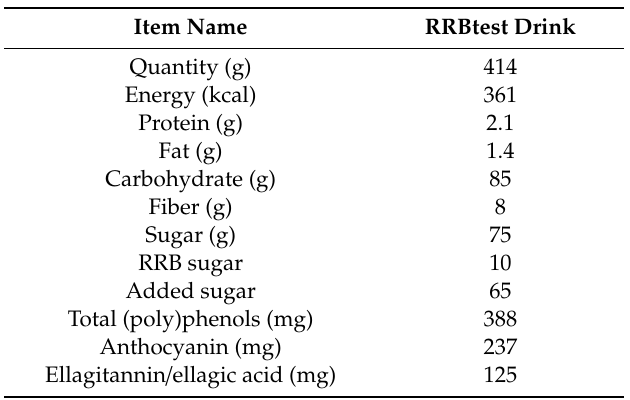
Table 1. Nutrient composition of red raspberry-based test drink (RRBtest) 1